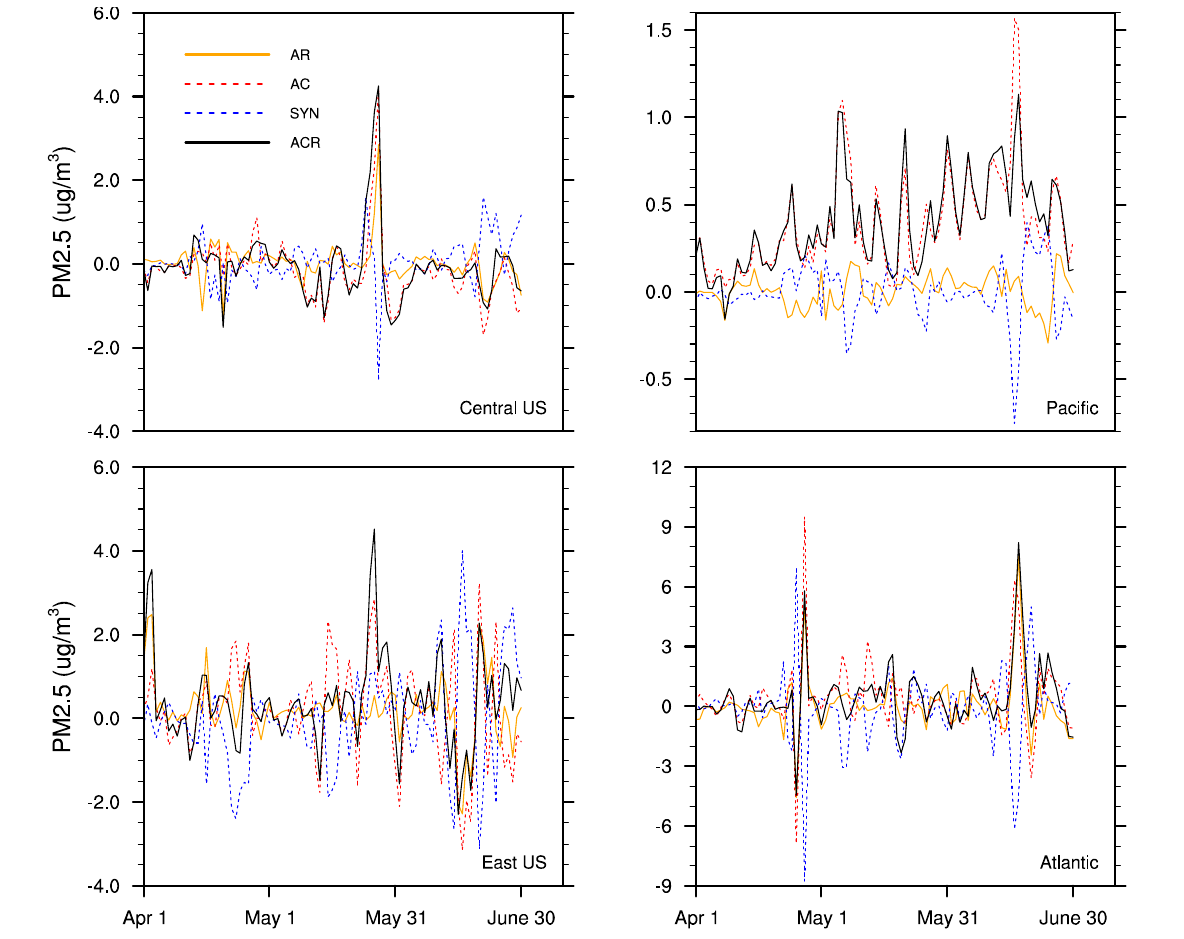
Figure 11. Same as Figure 10 except for surface PM2.5 concentration ( μ g·m − 3